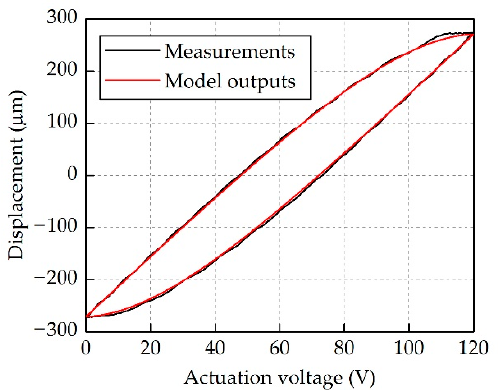
Figure 5. Flow chart of Particle Swarm Optimization (PSO) identification.